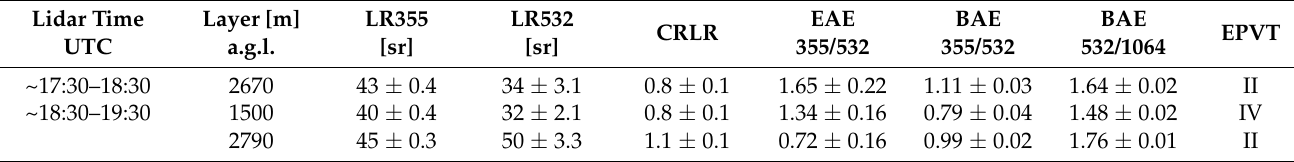
Figure 2. Lidar averaged profiles over ~18:30–19:30 UTC on 25 July 2016: aerosol backscatter coefficient at 355 nm, 532 nm, and 1064 nm ( left ) and aerosol extinction coefficient at 355 nm and 532 nm ( right ). The layers are marked (gray shaded) while the mean values of the optical properties in the layer are shown with the corresponding color for each parameter. Table 3. Intensive parameters for smoke layers detected on 25 July 2016, along with the associated burned land cover type (EPVT). Layer represents the mean layer